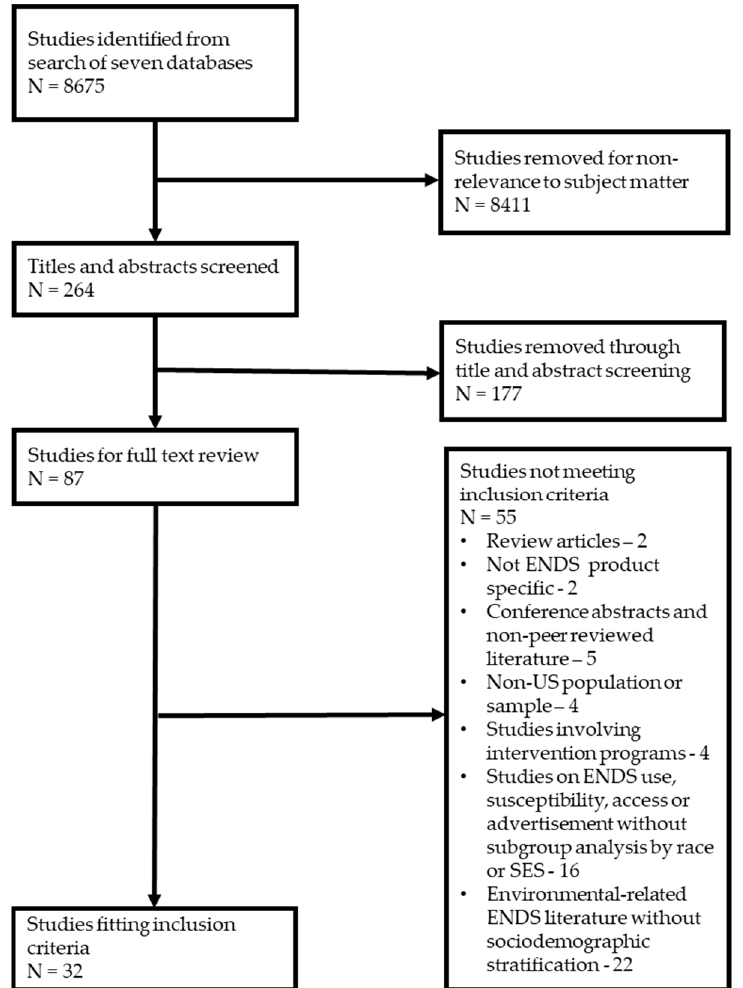
Figure 1. PRISMA flow